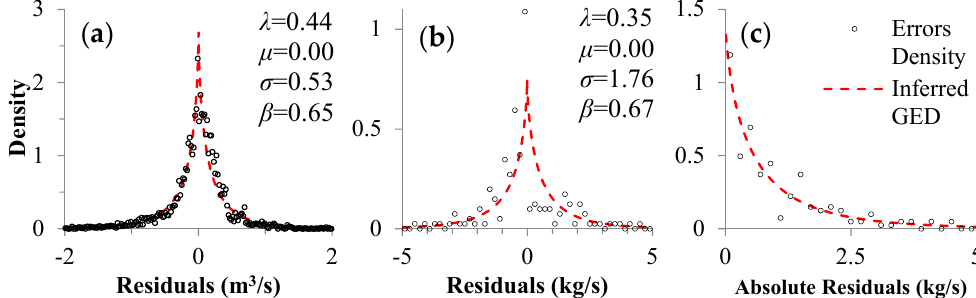
Figure 8. Empirical probability density (black circle) of model residuals versus the inferred GED (red dash line): ( a ) Flow; ( b ) Sediment; and ( c ) Absolute residuals of sediment.